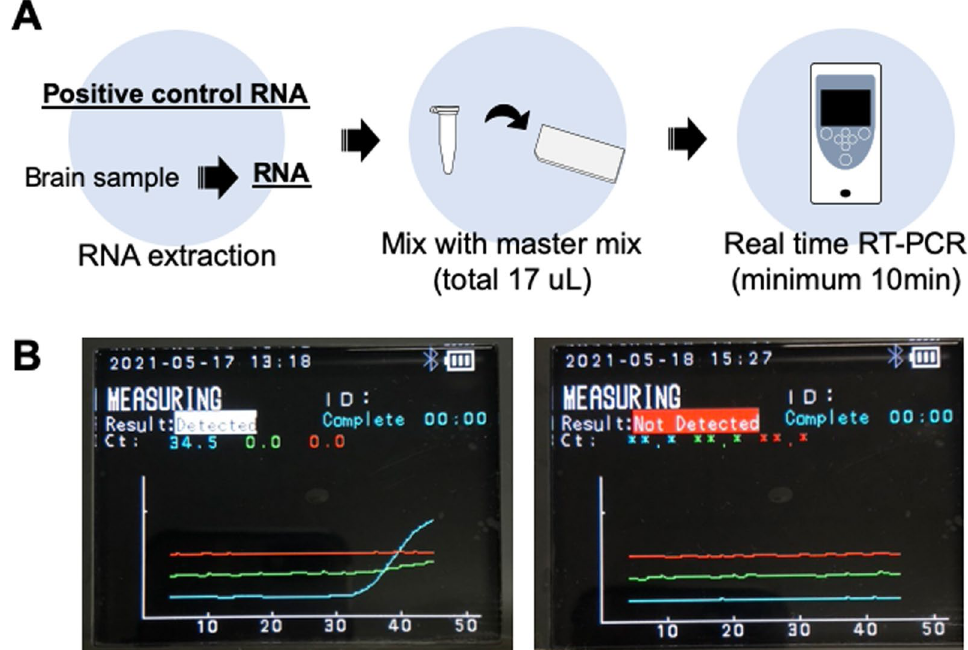
Fig. 1 Overview of the PCR1100 assay. A Schematic illustration of the workflow of the real-time RT-PCR procedure used in this study. B Once the PCR reaction is complete, the amplification curve and results are displayed on the monitor. The left panel shows a positive result, whereas the right panel shows a negative result. Blue, green, and red lines indicate FAM, VIC, and Cy5 fluorescence,